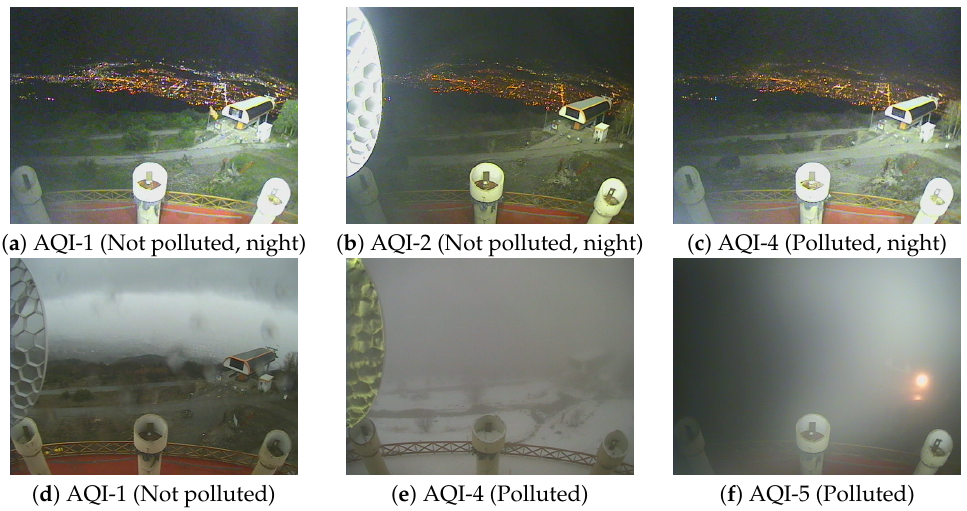
Figure 12. Exemplary images in the dataset in the different classes during the night or other weather conditions with limited